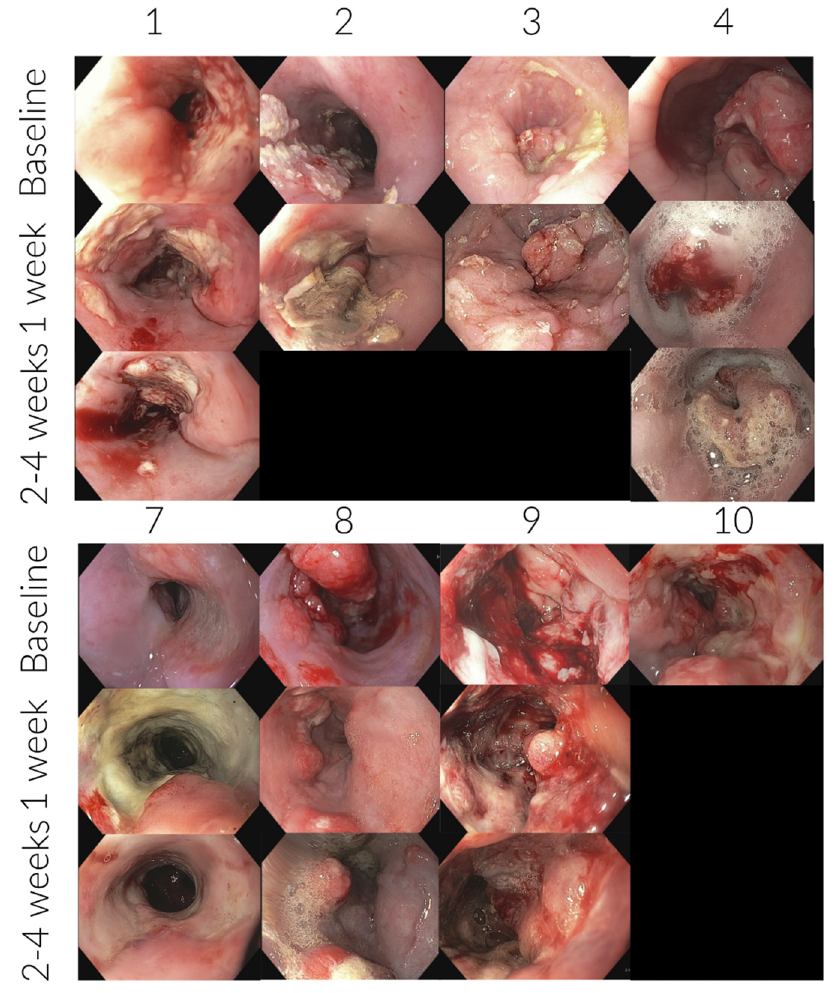
Figure 3. Endoscopic findings, patient ID 1-10 (only patients who received treatment). Endoscopic images from the tumor site before treatment and again at follow-up. It is clear to see that already within the first week, in most of the patients, the treated area is covered by a fibrin layer. In no patients was a total visual response seen.